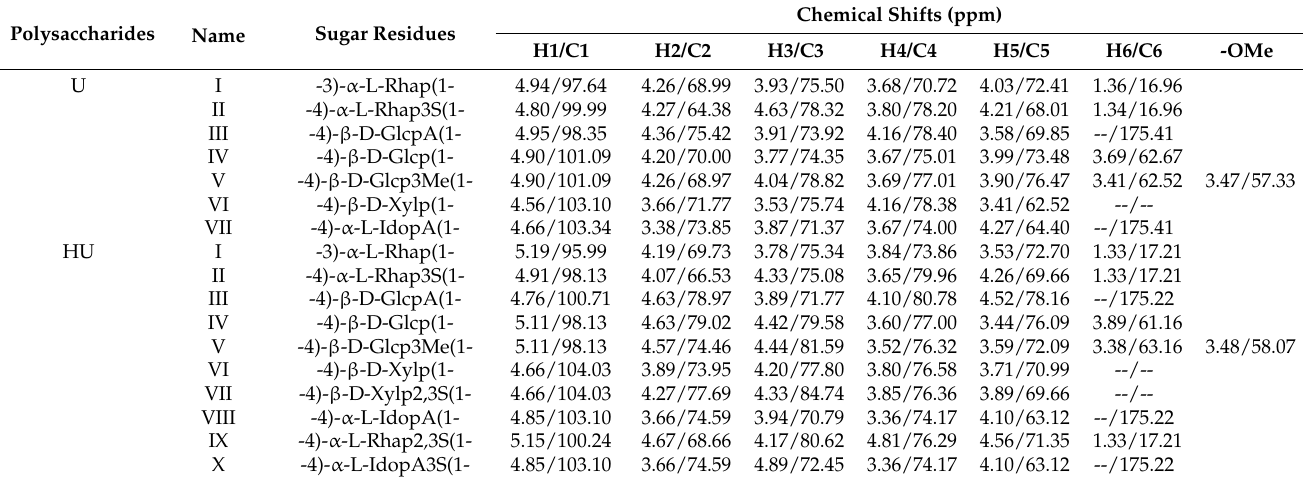
Table 2. 1 H and 3 C NMR chemical shifts of U and HU recorded in D 2